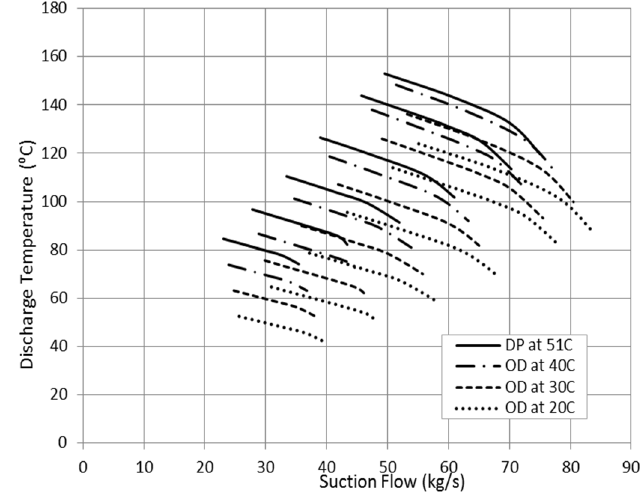
Figure 8. Effect of gas temperature on the compressor discharge